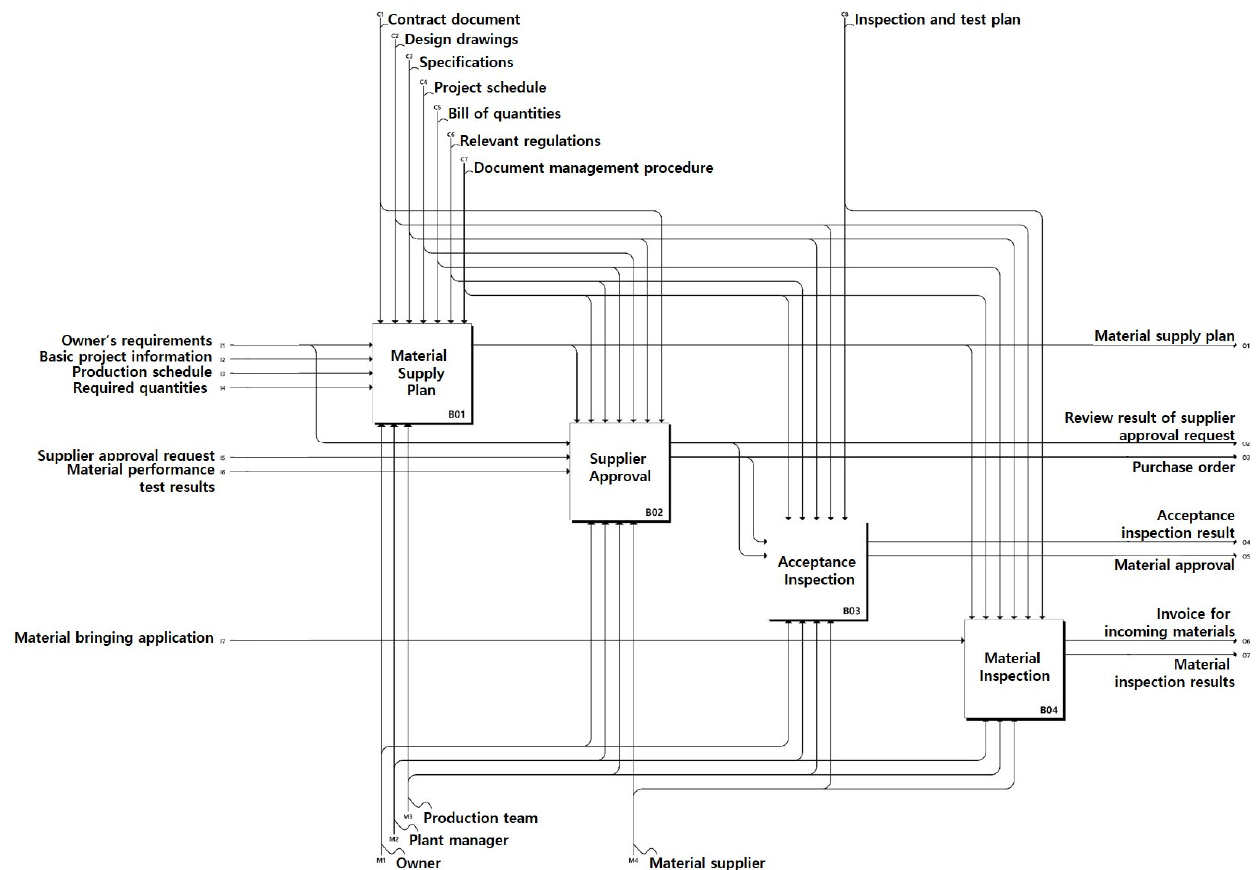
Figure 4. IDEF0 modeling results for quality management in material management.